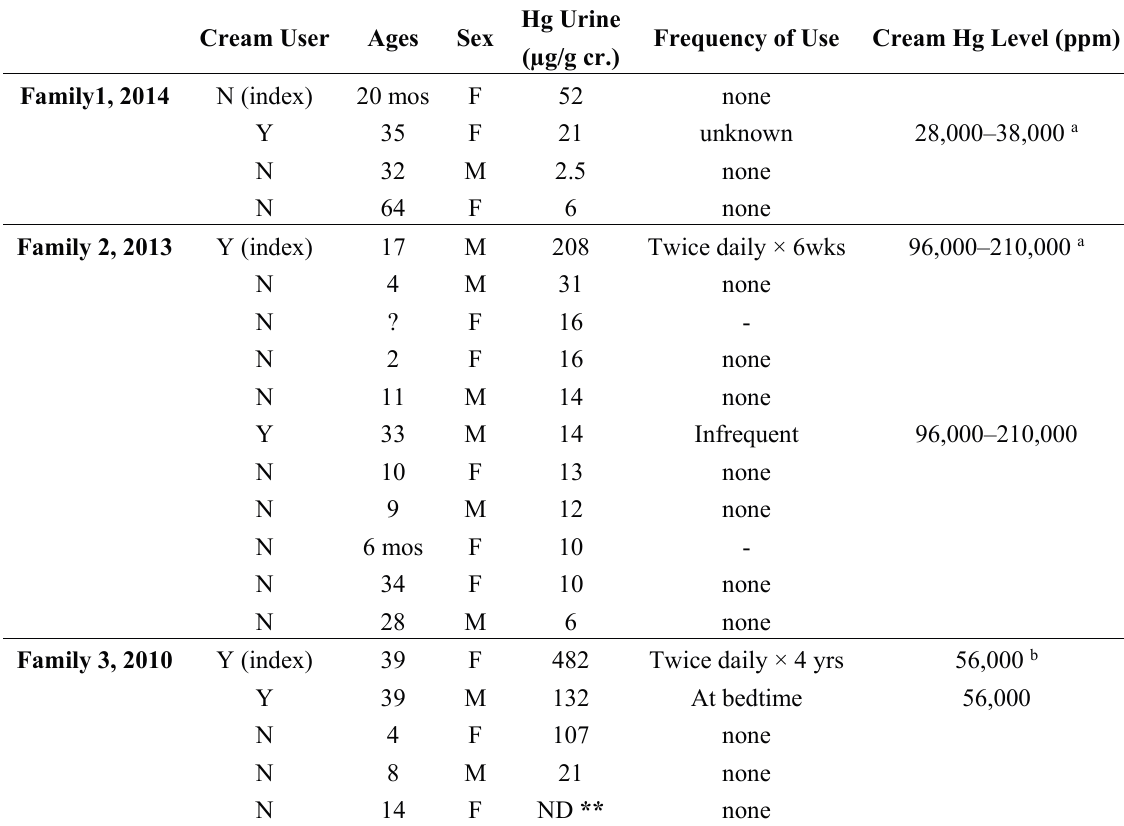
Table 1. Cases in three family units, with individual urinary mercury levels and mercury cream concentrations. Hg Urine Frequency of Cream User Ages Sex (µg/g cr.)